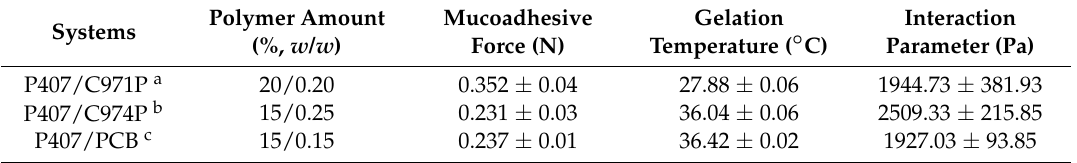
Table 2. Mucoadhesive profile (using porcine mucin disk), gelation temperature, and rheological interaction parameter of the selected formulations containing poloxamer 407 (P407) and Cabopol 971P